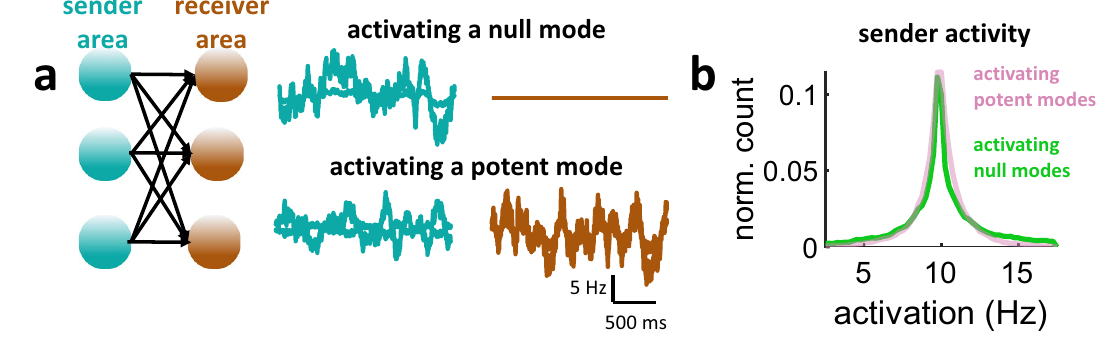
Figure 2. Toy example of a network with three sender and receiver neurons. ( a ) Activating a null mode led to no response in the receiver area. Conversely, activating a potent mode generated a response in both the sender and receiver areas. ( b ) Distribution of activity from the sender area when activating either a null or potent